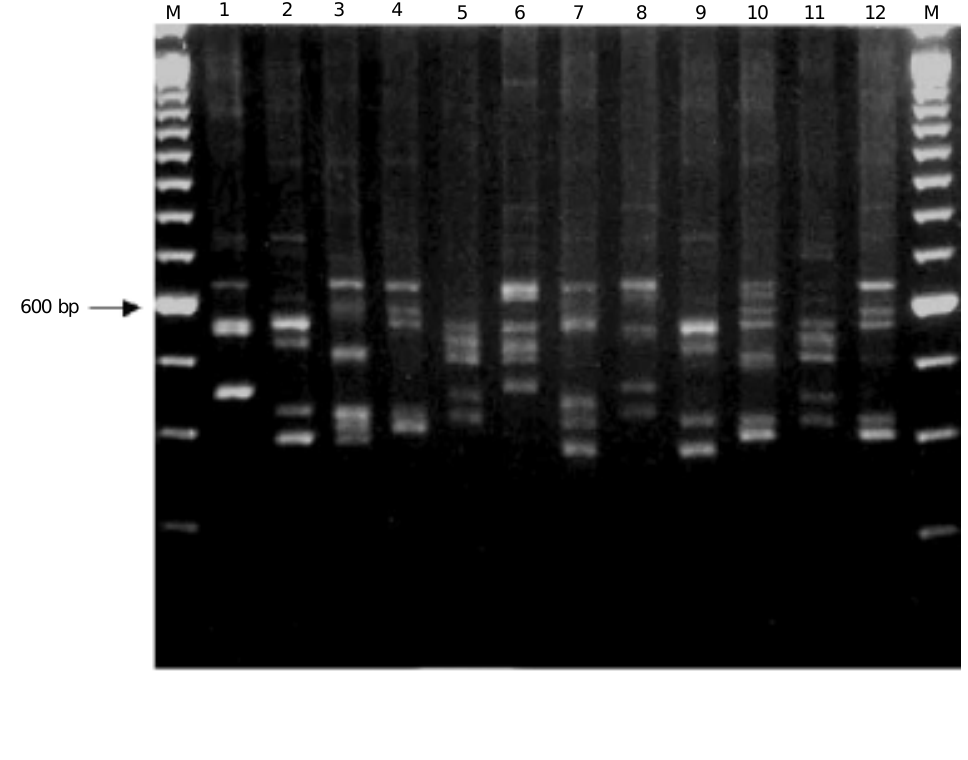
Figure 4. Electrophoretic pat- terns of PCR ribotypes of 12 methicillin-resistant S. aureus isolates (lanes 1 to 12). Lane M: 100-bp